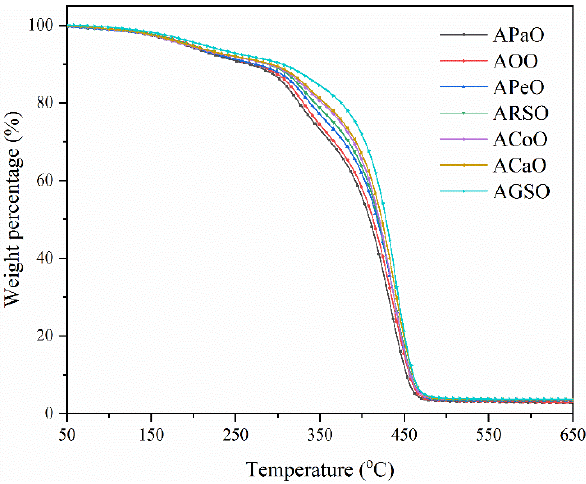
Figure 4. Thermo-gravimetric analysis (TGA) results of the UV-cured films. Table 3. Thermal stability of the UV-cured films.